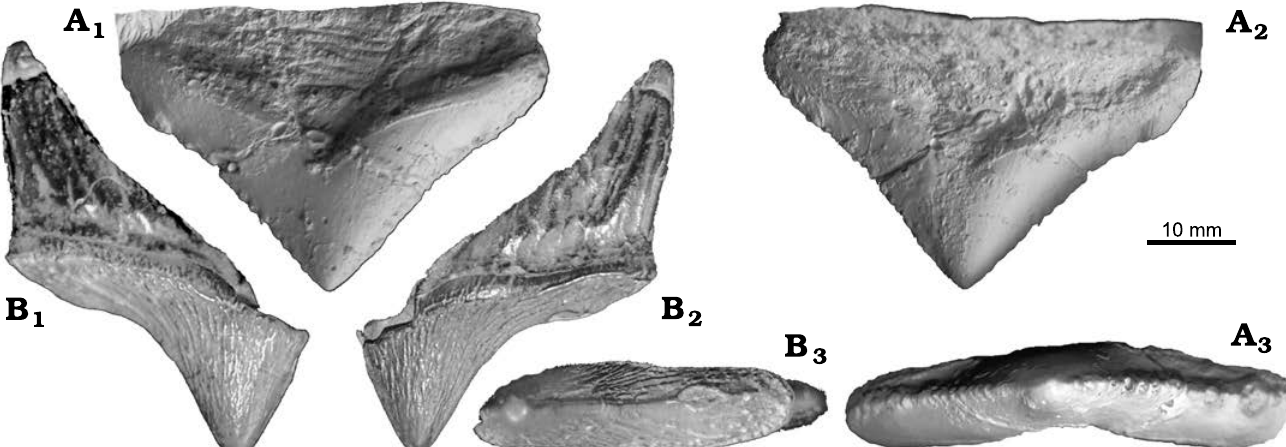
Fig. 2. A . Remingtonocetus sp. (IITR-SB 2630) from Lutetian; Kachchh, India; right P4. B . ?Remingtonocetidae indet. (USNM 449550) from Lutetian– Bartonian; Martin Marietta Quarry (formerly Superior Stone Quarry), near Castle Hayne, North Carolina, USA. Shown as if it were an upper premolar for comparison, but it may also represent a lower premolar as well. Note the extreme narrowness of the tooth. In lateral (A 2 , B 2 ), medial (A 1 , B 1 ), and occlusal (A 3 , B 3 )